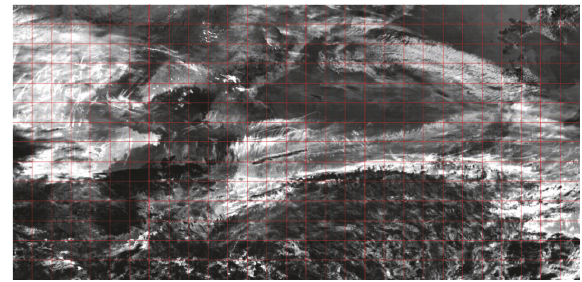
Figure 2: BTD image (band (13) –band (15) ) with 1 ∘ ×1 ∘ degree grid boxes (115 ∘ E–144 ∘ E, 30 ∘ N–44 ∘ N).